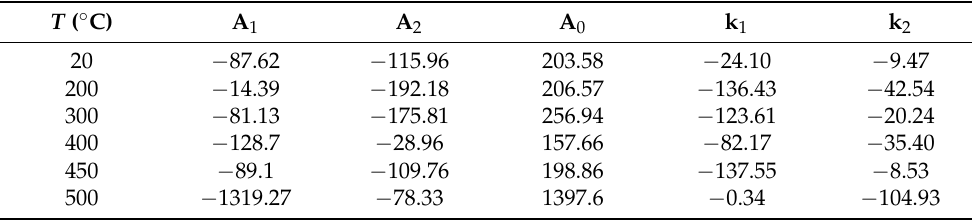
Table 5. Values of the parameters in Equation